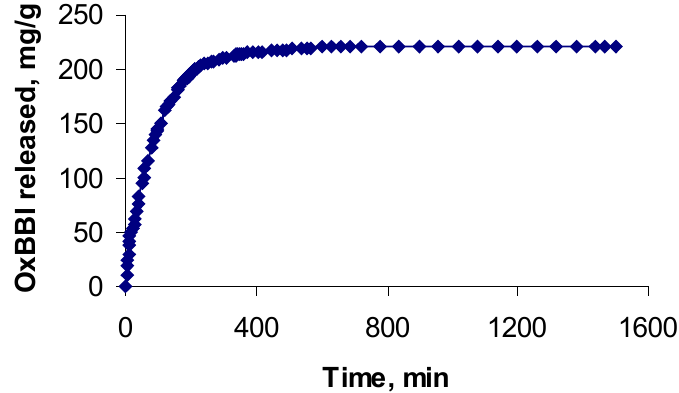
Figure 7. Time variation of the amount of OxBBI released from the coupling product, in a basic medium (OxBBI content = 22.29